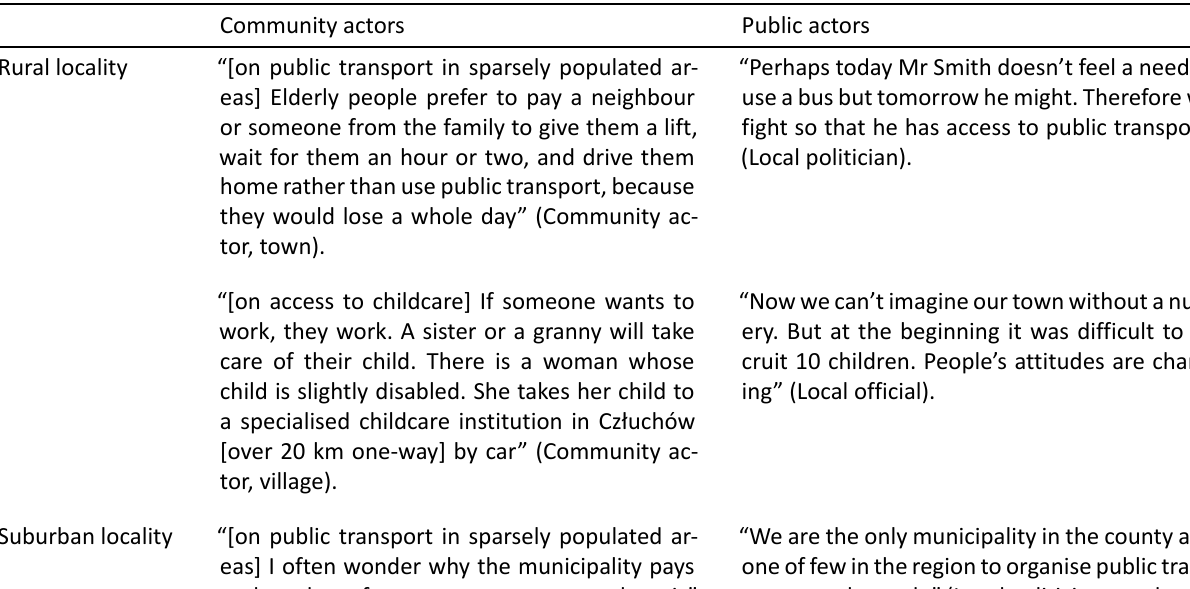
Table 3. Comparison of views on significance of access to public